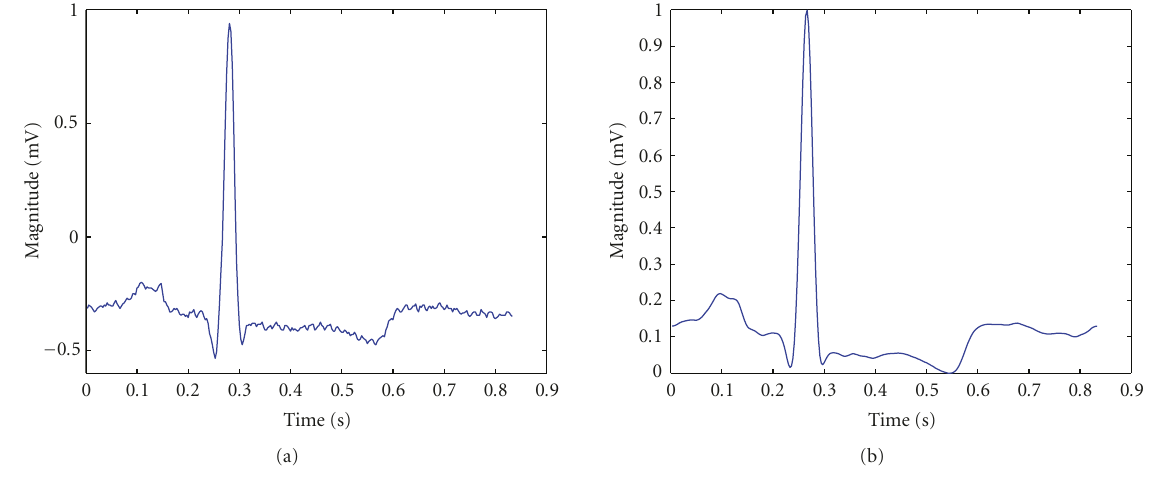
Figure 2: (a) An ECG pattern and (b) its processed